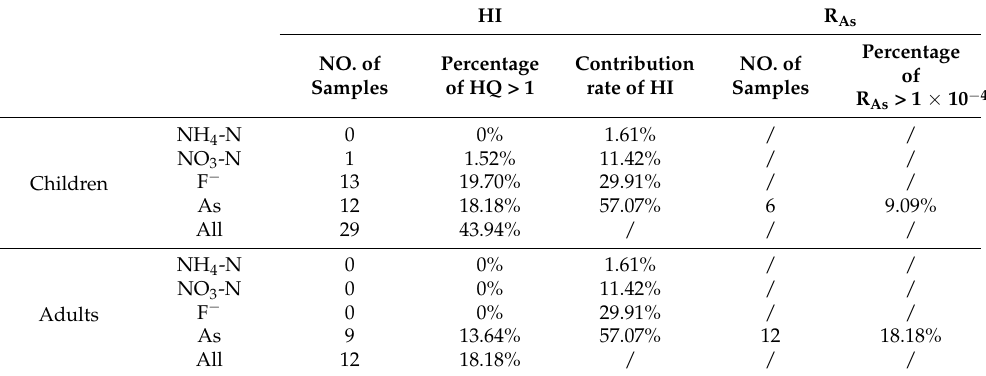
Figure 10. Non-carcinogenic risk zoning map in Shizuishan area. ( a ) NH 4 -N for children; ( b ) NO 3 -N for children; ( c ) F − for children; ( d ) As for children; ( e ) NH 4 -N for adults; ( f ) NO 3 -N for adults; ( g ) F − for adults; ( h ) As for adults; ( i ) all for children; ( j ) all for adults. The blue line represents the critical HI value. Table 4. Non-carcinogenic and carcinogenic risk results of Shizuishan area through drinking water